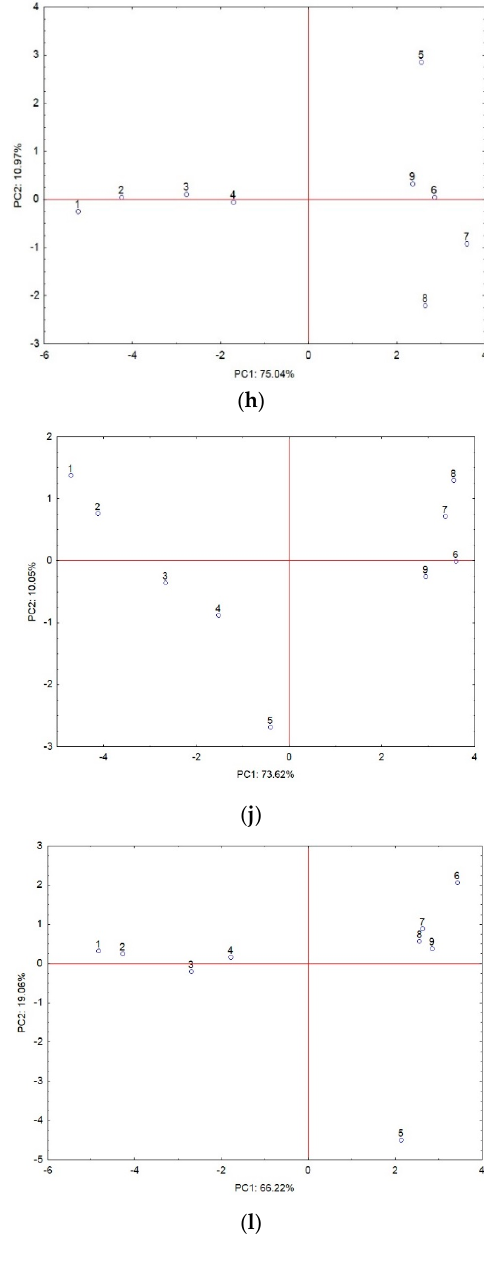
Figure 1. Loading plot ( a ) and score plot ( b ) of the principal component analysis carried out for chemical groups and sensor responses to changes in VOCs for nine days of corn grain storage at 14% (w.b.) moisture and 0 kPa consolidation. Loading plot ( c ) and score plot ( d ) of the principal component analysis carried out for chemical groups and sensor responses to changes in VOCs for nine days of corn grain storage at 17% (w.b.) moisture and 0 kPa consolidation. Loading plot ( e ) and score plot ( f ) of the principal component analysis carried out for chemical groups and sensor responses to changes in VOCs for nine days of corn grain storage at 14% (w.b.) moisture and 40 kPa consolidation. Loading plot ( g ) and score plot ( h ) of the principal component analysis carried out for chemical groups and sensor responses to changes in VOCs for nine days of corn grain storage at 17% (w.b.) moisture and 40 kPa consolidation. Loading plot ( i ) and score plot ( j ) of the principal component analysis carried out for chemical groups and sensor responses to changes in VOCs for nine days of corn grain storage at 14% (w.b.) moisture and 80 kPa consolidation. Loading plot ( k ) and score plot ( l ) of the principal component analysis carried out for chemical groups and sensor responses to changes in VOCs for nine days of corn grain storage at 17% (w.b.) moisture and 80 kPa